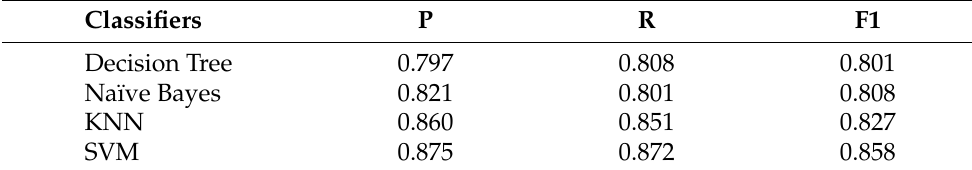
Table 4. On-spot detection results obtained from multiple